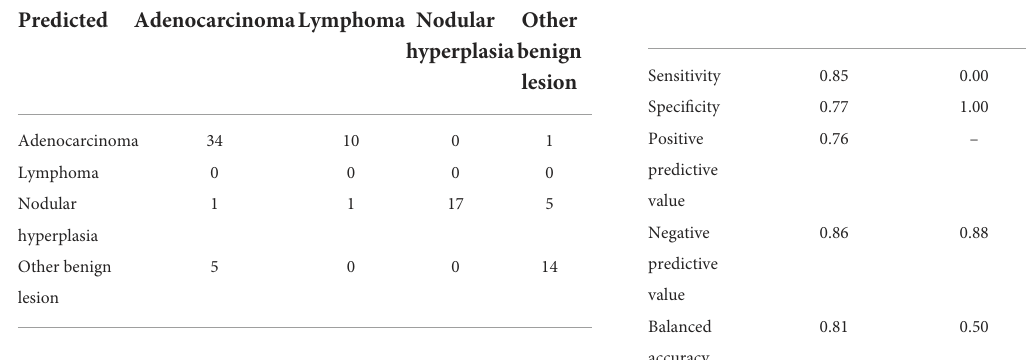
TABLE 6 Results of the classification of the pancreatic lesions based on the machine learning-based decision